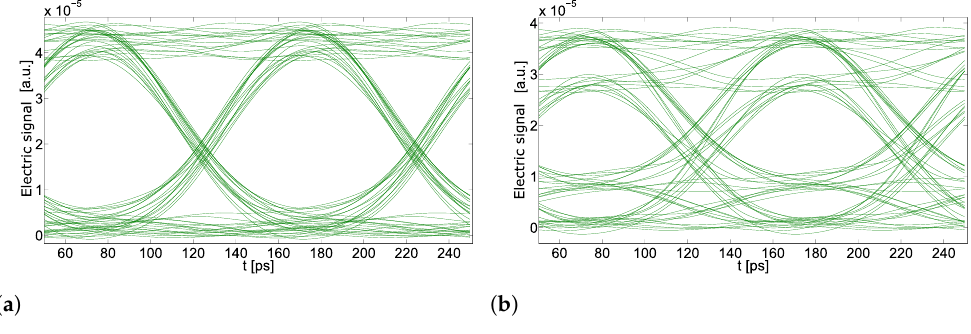
Figure 14. Eye diagram for different PER settings-( a ) 10dB, ( b )